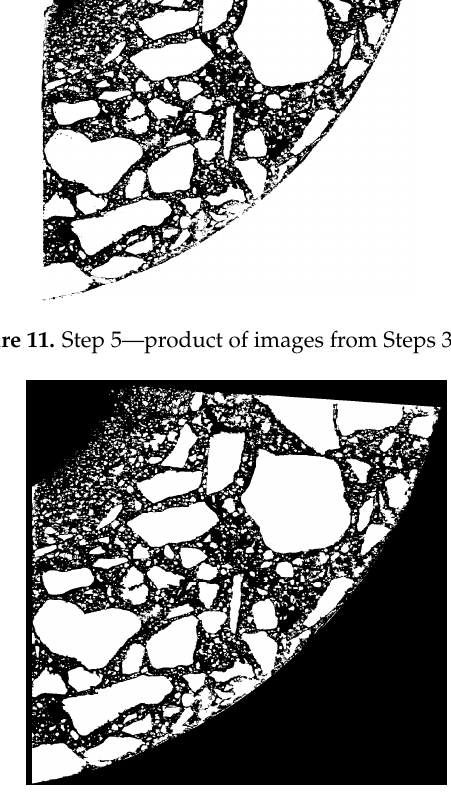
Figure 12. Step 6—the removal of “pores”.